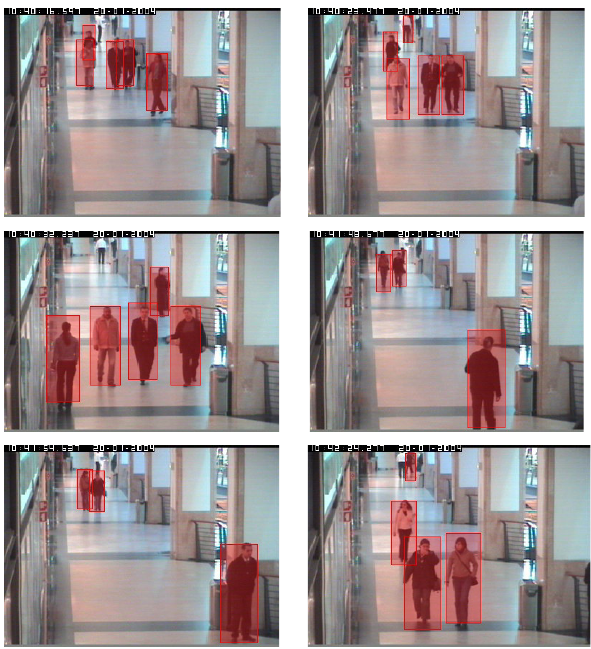
Figure 8. Some illustration person detection results of the classifier grids for the Caviar